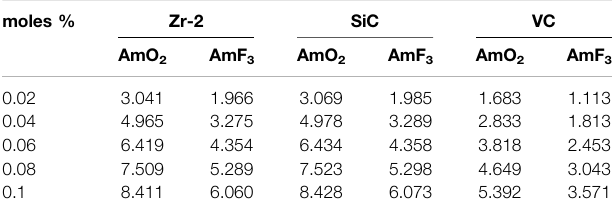
TABLE 1 | The integrated heating (Watt/gr) for Zr-2, SiC, and VC clads, the fuel components AmO 2 and AmF 3 in the BWR system.